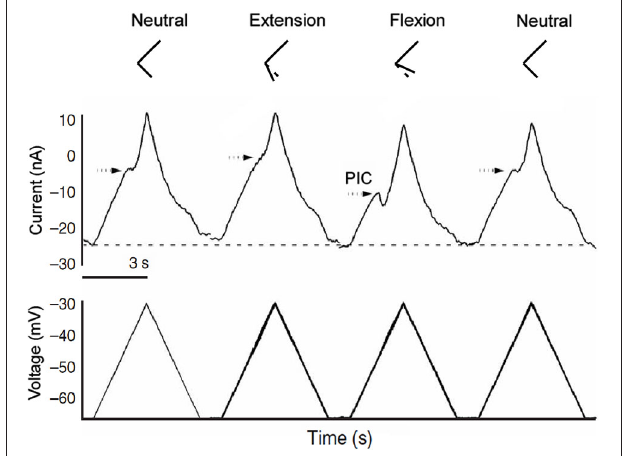
FIGURE 1 | Ia reciprocal connections to spinal motoneurons by antagonist muscle pairs . Rotating the joint to stretch flexor muscles provides disynaptic inhibition to extensor motoneurons and direct activation of the flexor motoneuron ( A , solid lines). The opposite rotation stretches extensor muscles providing disynaptic inhibition to flexor motoneurons and direct activation of the extensor motoneuron ( B , solid lines). The plus and minus signs in this figure are meant to indicate net depolarization (+) and net